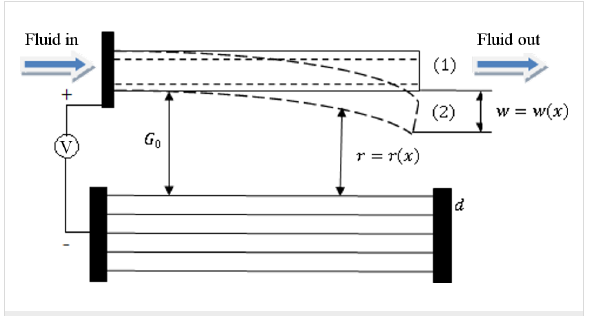
Figure 1: Application of an external force on a nanotube and its local